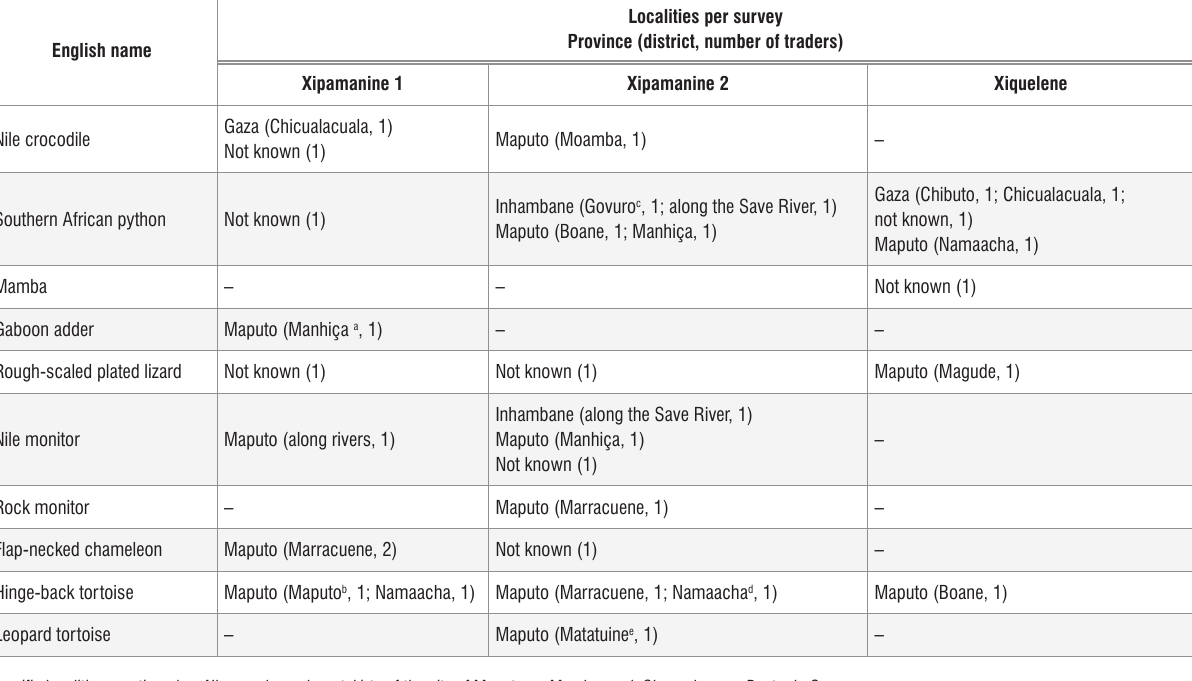
Table 4: Harvesting localities/sources for reptiles sold in the markets